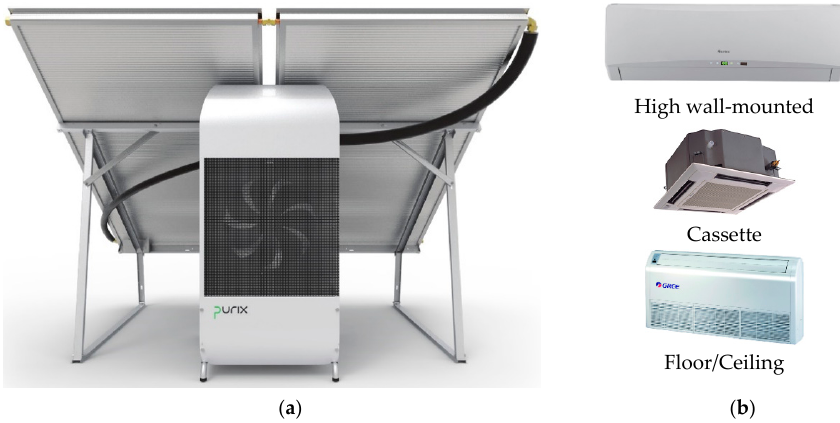
Figure 2. A modular stand ‐ alone, small ‐ scale solar space cooling system developed and commercialized by PURIX ApS (type A25s). (a) Outdoor unit: ASC and two flat ‐ plate solar collectors; (b) Indoor unit: fan coil types. Adapted from References [19,20]. Note: ASC=air ‐ cooled small